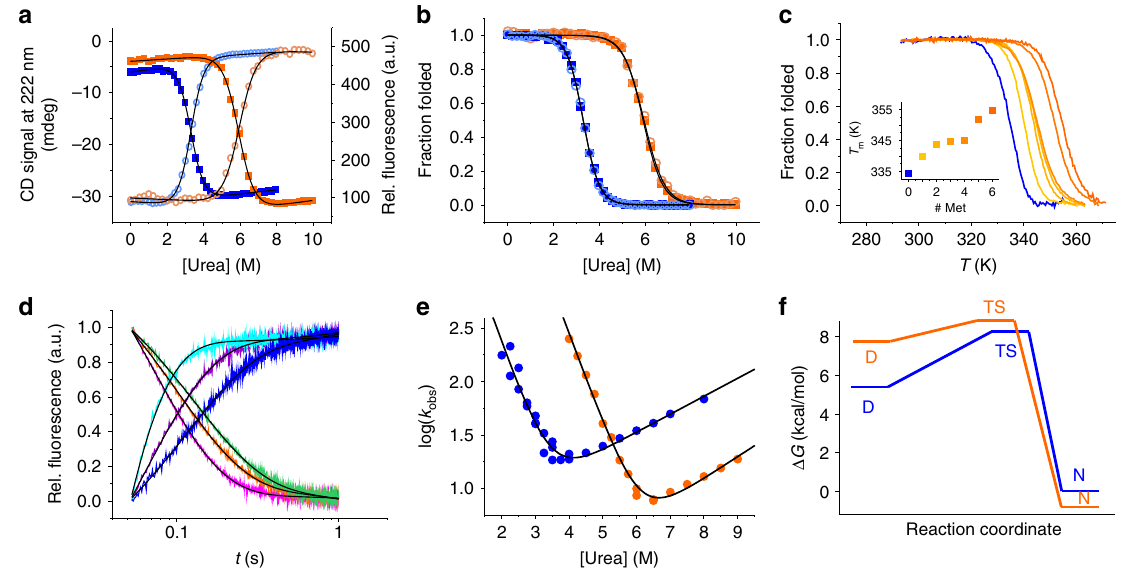
Fig. 2 Equilibrium denaturation and folding kinetics of L6-NTD at pH 7.0. a Chemical denaturation of L6-NTD (orange) and WT-NTD (blue) measured using far-UV CD spectroscopy (light open circles) and Trp fl uorescence at 325 nm (closed squares). Black lines are fi ts to the data using a thermodynamic model for a two-state equilibrium. b Data shown in a but normalized to the fraction of folded protein. Same symbol and color code applies. c Thermal denaturation of six cumulative Met-to-Leu mutants (blue to orange) measured using far-UV CD spectroscopy. Data are normalized to the fraction of folded protein. The increase of transition midpoint ( T m ) rank-orders with the cumulative number of mutations (inset). d Kinetic transients of folding (cyan, violet, blue; 5.0, 5.5, 6.0 M urea, respectively) and of unfolding (green, orange, magenta; 6.5; 7.5, 8.5 M urea, respectively) of L6-NTD measured using stopped- fl ow Trp fl uorescence spectroscopy. Signal amplitudes were normalized for reasons of clarity. Data were fi tted using a mono-exponential decay function (black lines). e Observed rate constants (WT-NTD: blue, L6-NTD: orange) plotted versus concentration of urea (chevron plot). Data were fi tted using a model for a barrier-limited two-state transition (black lines). f Free-energy pro fi le of folding of WT-NTD (blue) and L6-NTD (orange) inferred from equilibrium and kinetic denaturation data. D Denatured state, TS transition state, and N native state are indicated. The free energy of the native state of WT-NTD was set as a reference state to zero kcal/mol. Source data are provided as Source Data fi le